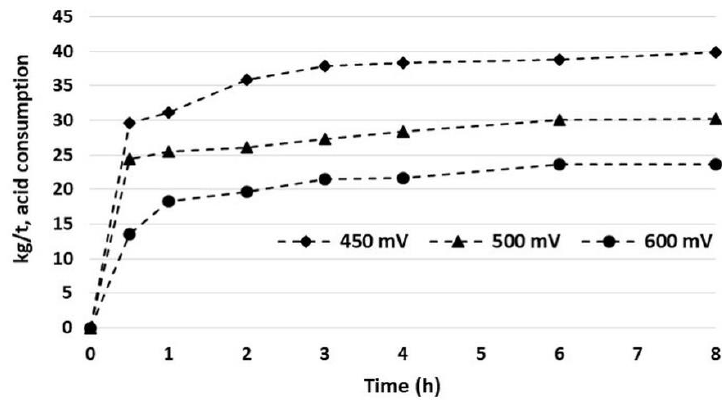
Figure 11. Sulfuric acid consumption under reducing conditions using FeSO 4 (40 g/L). Solution potential controlled at 450 mV ( ); 500 mV ( ▲ ); and 600 mV (●), at 25 °C and using 50 g/L H 2 SO 4 .